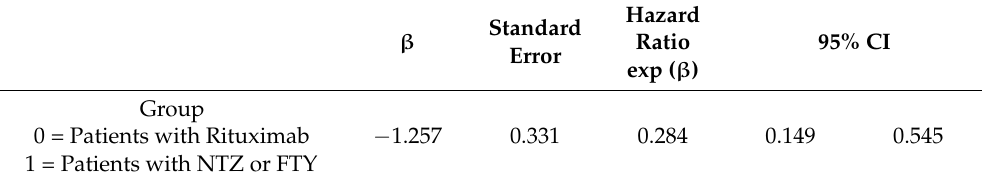
Table 3. Cox regression analysis. Figure 1. Box plots show medians, quartiles, and 25th and 75th percentiles. EDSSi (initial EDSS); EDSSf (final EDSS); Δ EDSS (change in EDSS after 12 months of treatment; NTZFTY (natalizumab or fingolimod); RTX (rituximab).